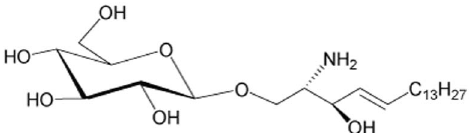
considered and a careful analysis yielded a cut-off of 12 ng/ml with an ideal sensitivity and specificity of 100% (data for other calculated cut-offs not shown). This observation was independent of gender (Figure 3B), levels of Glucosylsphingosine being similar in male and female GD patients. Notably, neither healthy probands, patients with other LSDs nor GD carriers exhibited pathologic values above the cut-off of 12 ng/ml (Figure 3A). Only GD patients displayed Glucosylsphingosine values above the normal range.